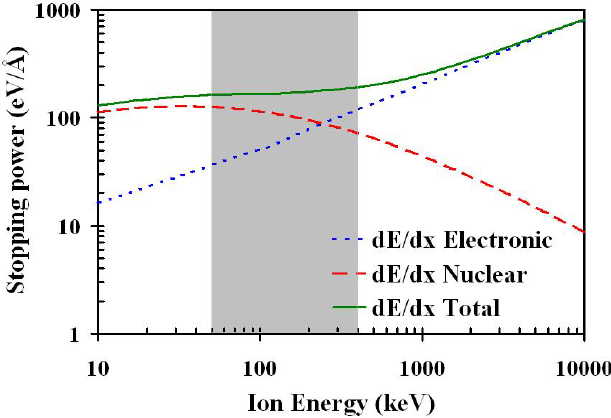
FIG. 1. (Color) Stopping power for K (cid:1) ions hitting stainless steel target, from TRIM 2003